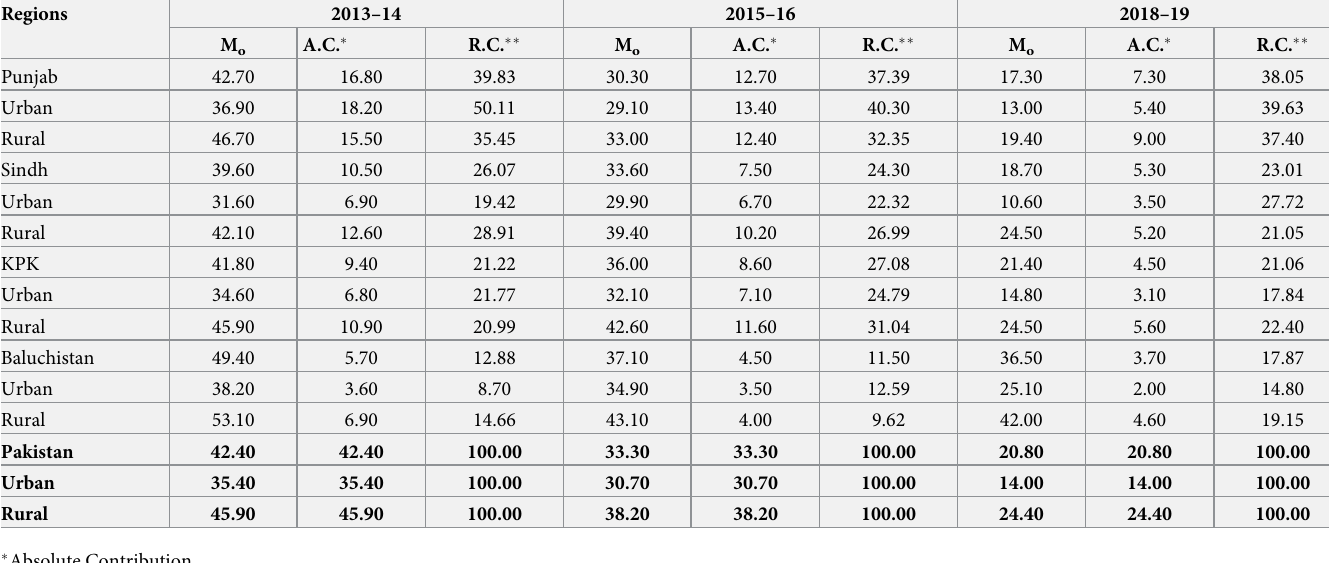
Table 3. Decomposition analysis of multidimensional health poverty: 2013–14 to 2018–19.